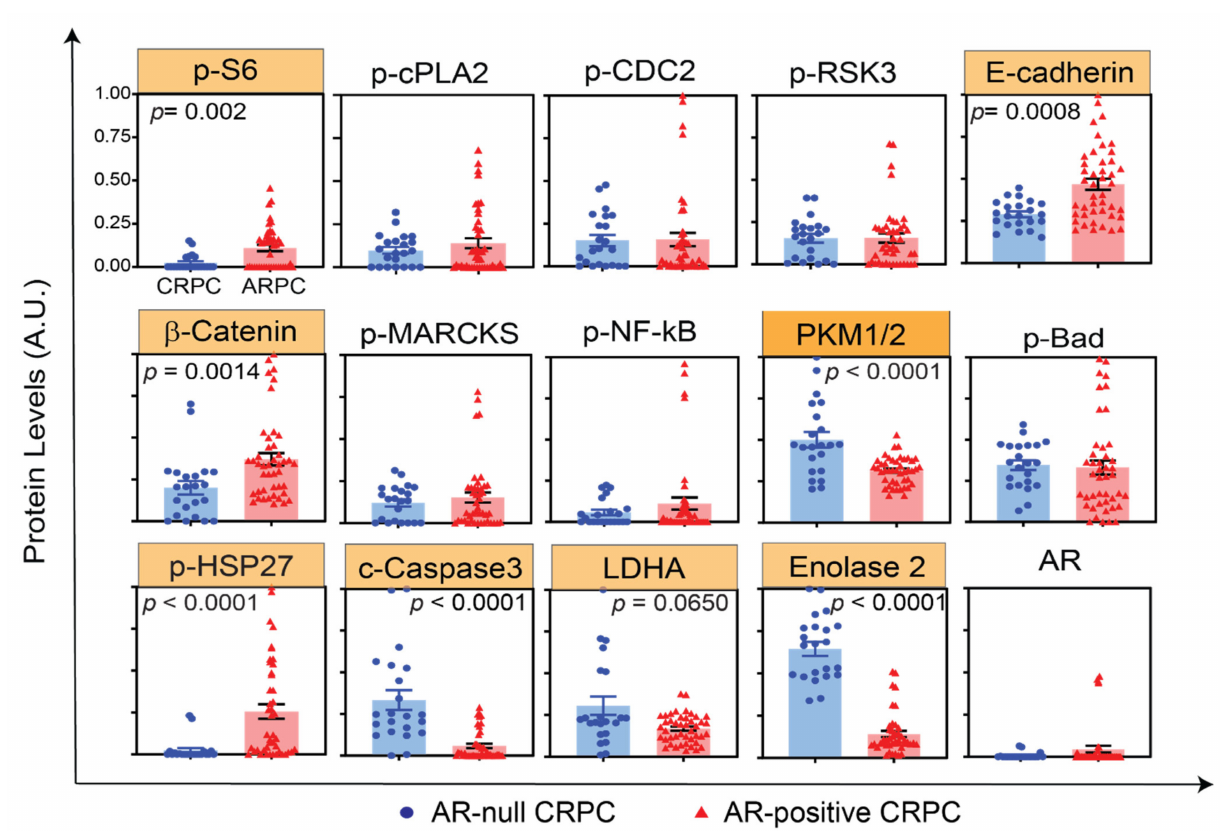
Figure 2. RPPA profiling of LuCaP PDX tumors identifies previously known markers of AR-null and AR-positive CRPC. Representative plots showing 12 different proteomic measurements in 22 AR-null (blue) and 44 AR-positive (red) tumor lysate samples. The proteins highlighted in yellow indicate statistically significant results ( p <